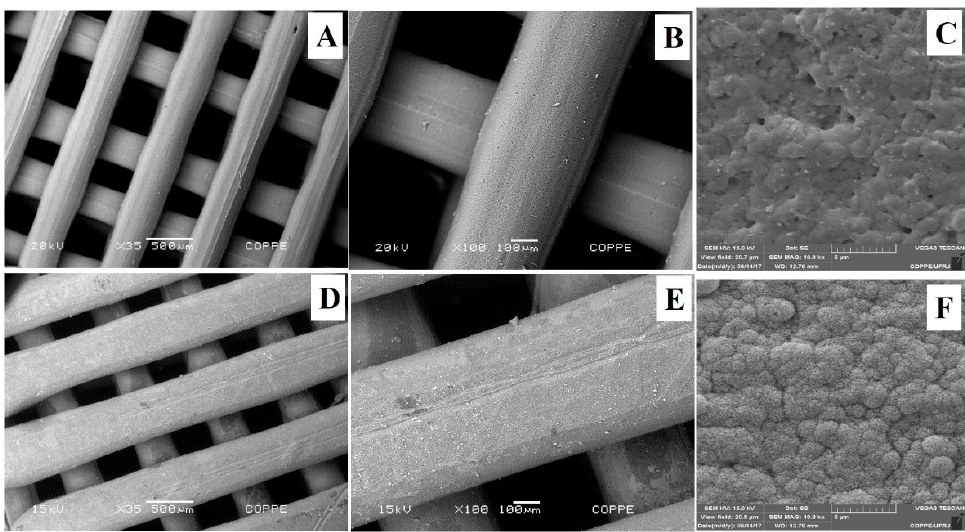
Figure 3. SEM micrographs of scaffolds before ( A – C ) and after CaP coating ( E – G ).